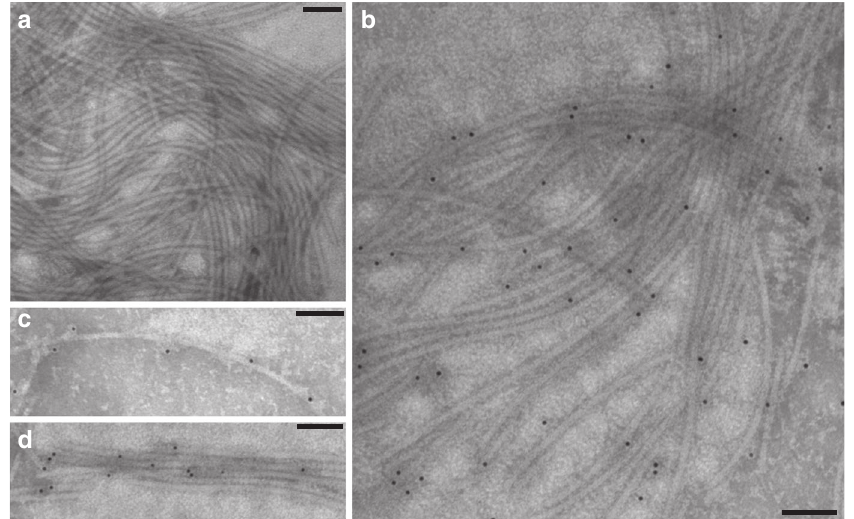
Fig. 5 Immunogold electron microscopy of intact fl agellar fi laments from C . haemolyticum . a Flagellar fi laments (control lacking antibody). b Flagellar fi laments labeled with gold 10-nm nanoparticle-conjugated af fi nity puri fi ed polyclonal antibodies raised against the C . haemolyticum fl agellin FliA(H)- hypervariable region metallopeptidase domain. Gold nanoparticles can be seen decorating the surface of individual fl agellar fi laments c and fl agellar bundles d , revealing that the metallopeptidase domains are surface-exposed and distributed evenly throughout fi laments. Scale bars are 100 nm in